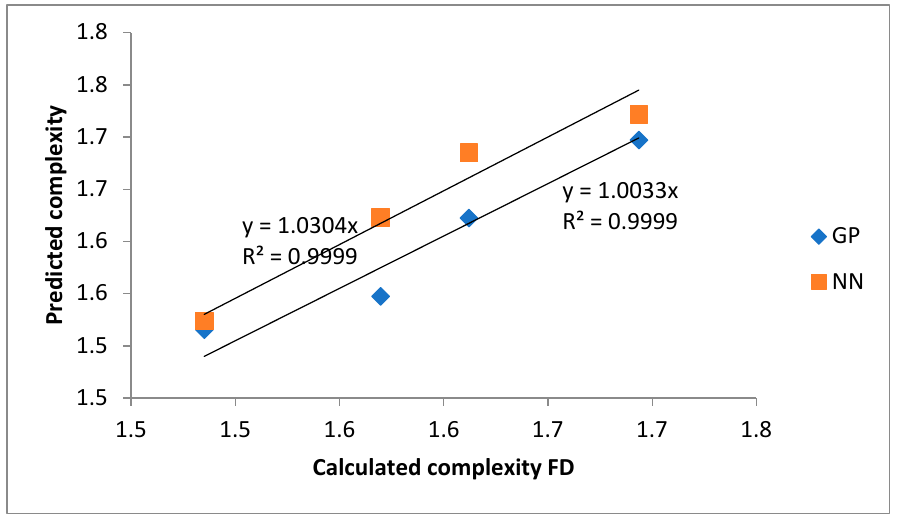
Figure 7 . A graphical representation of data with the correlation of determination. It is the case of FD (Complexity) with coefficients.